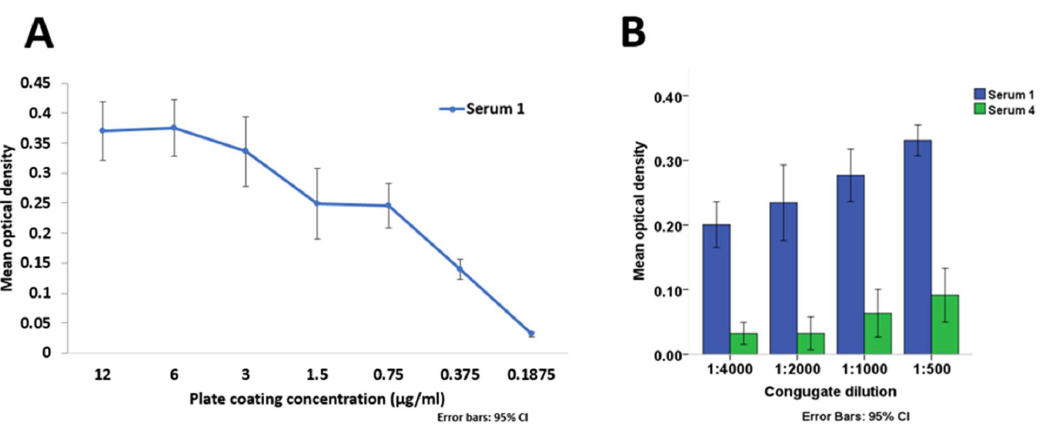
Figure 3. Mean optical densities of HCoV-NL63-rIFA-positive serum with coating concentrations ranging from 12 μg/mL to 0.1875 μg/mL ( Panel A ). Mean optical densities for the combined 5- and 15-min substrate incubation times for HCoV-NL63 rIFA-positive (Serum 1) and negative (Serum 4) sera with different conjugate dilutions ( Panel B ). Error bars depict 95% confidence intervals.